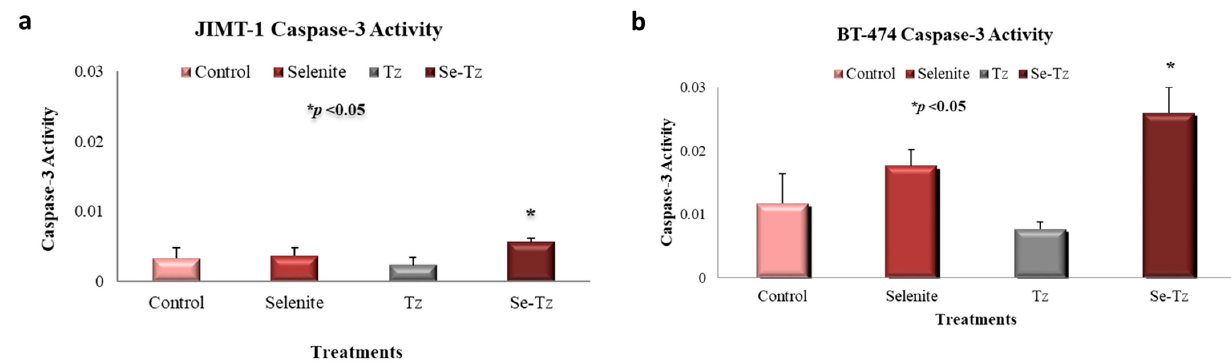
Figure 7. Caspase-3 activity from cell lines after selenium treatments. ( a ) JIMT-1 cells after 24 h of Trastuzumab and selenium treatments; ( b ) BT-474 cells after 72 h of Trastuzumab and selenium treatments. Cells were treated with Se-Tz at the concentration of 4.8 µ gSe/well and Tz cells were treated with an equal mab protein concentration. Selenite was used as a redox toxic positive control at a concentration of 10 µ gSe/well. Selenite at concentrations less than 10 µ gSe/well had no visible effect on cancer cell lines under these experimental conditions.